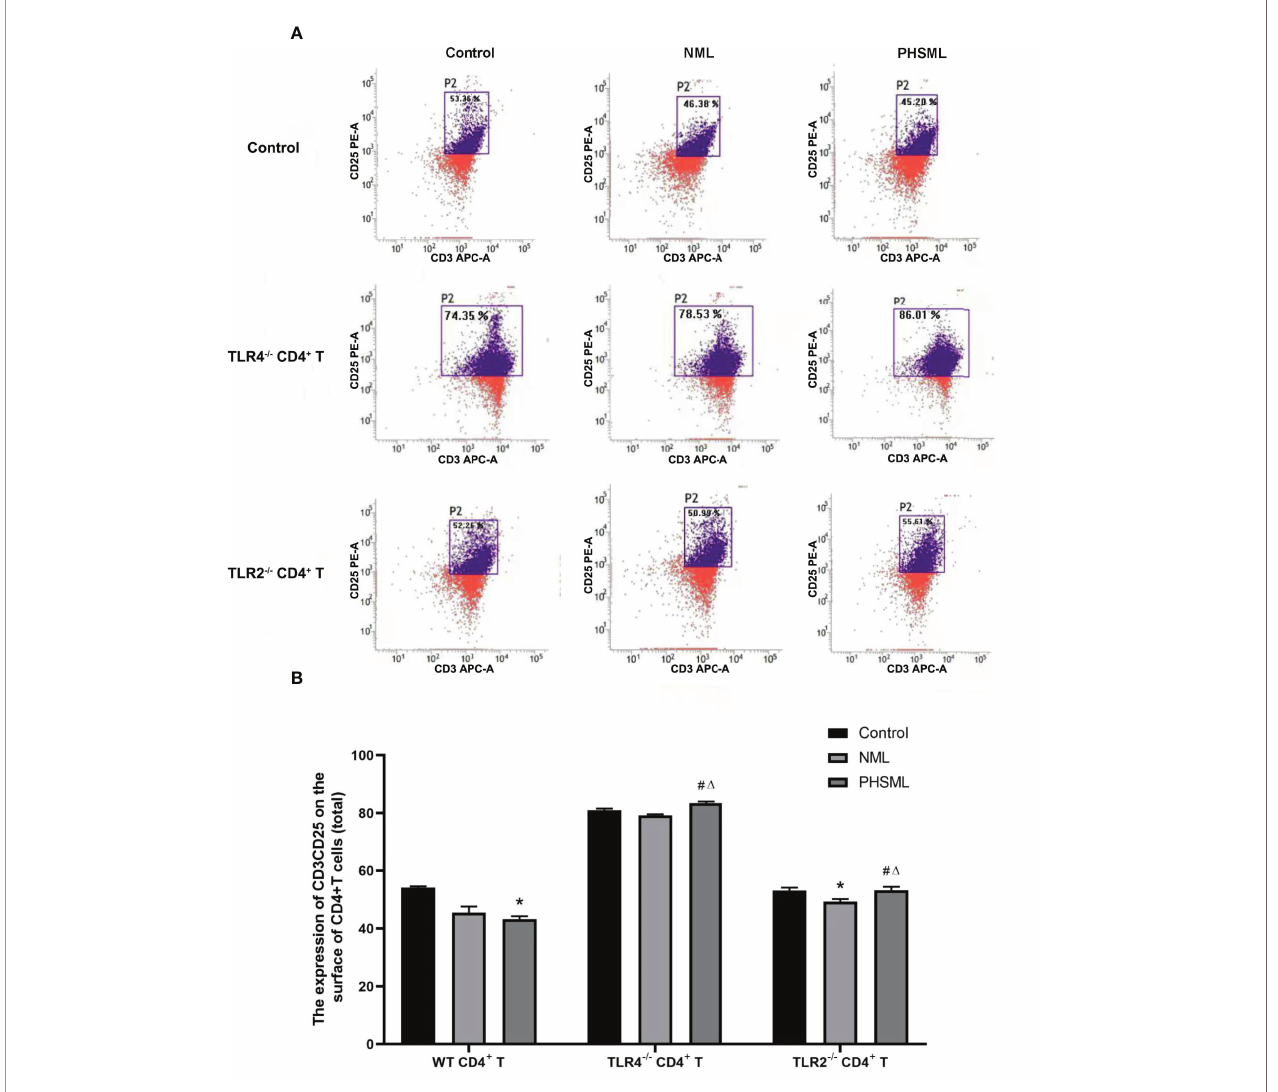
FIGURE 4 | The expression of CD25 on CD4 + T lymphocytes from WT, TLR2 -/- or TLR4 -/- mice stimulated with PHSML detected by fl ow cytometry. (A) Representative images. (B) The percentage of CD4 + T cells expressing CD25 is expressed as the mean ± SE and is shown in a bar graph. Data are derived from three independent experiments. *P < 0.05 vs control treated WT CD4 + T group, #P < 0.05 vs NML treated WT CD4 + T group, D P < 0.05 vs PHSML treated WT CD4 + T